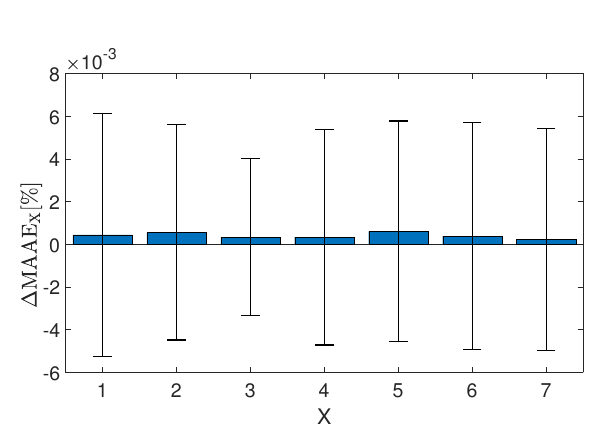
Figure 2. The bars are sorted by the increasing speedup from Figure 1 with the slowest on the left and the fastest on the right. We note that the increase of the prediction error is only of the order of 10 − 4 % with relatively large error bars, which indicate that all the values of ∆ MAAE coincide within the error bars and thus there is no trend of increasing the error with lowering